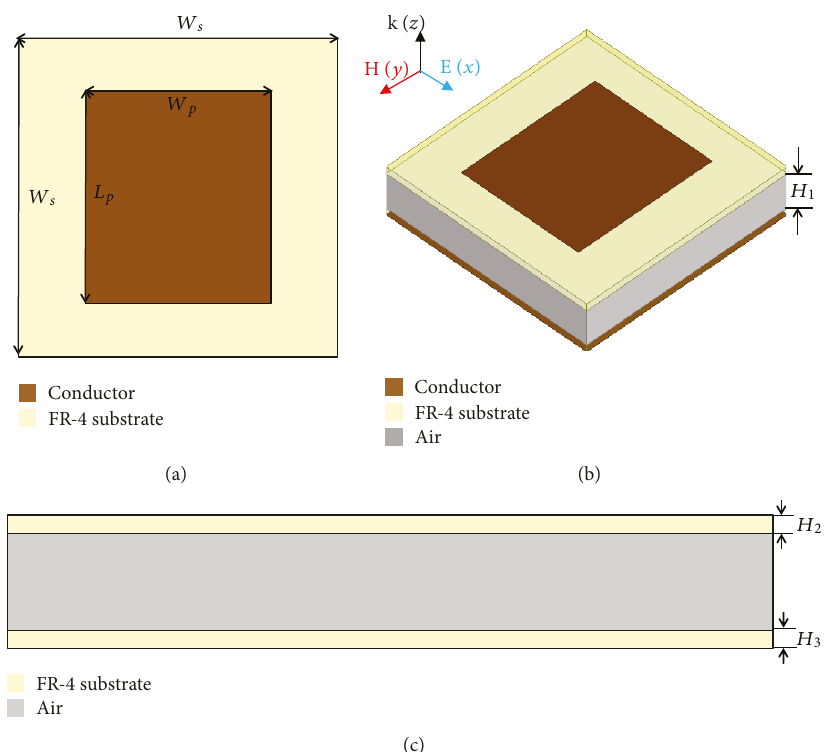
Figure 1: Geometry of the unit cell of the proposed absorber. (a) Top view of the unit cell. (b) Perspective view of the unit cell. (c) Side view of the unit cell. W s = 12mm ; L p = 8mm ; W p = 7 mm ; H